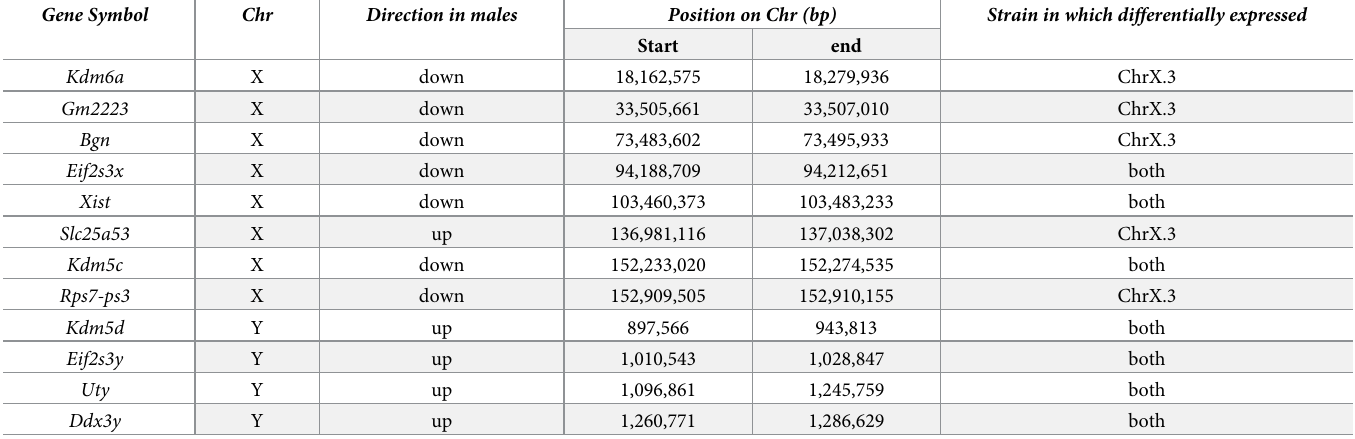
Table 4. Sex-dependent DEGs mapping to the sex chromosomes. Genes differentially expressed between males and females in: B6 mice only (B6; none in this category), ChrX.3 mice only (ChrX.3), or in both strains (both) which mapped to ChrX or ChrY, from the RNAseq data described in Fig 6 . Direction of change: up indicates increased expression in males relative to females, down indicates increased expression in females relative to males. A cutoff filter of Padj = < 0.05 was used to identify DEGs, without a fold change cutoff. Gene